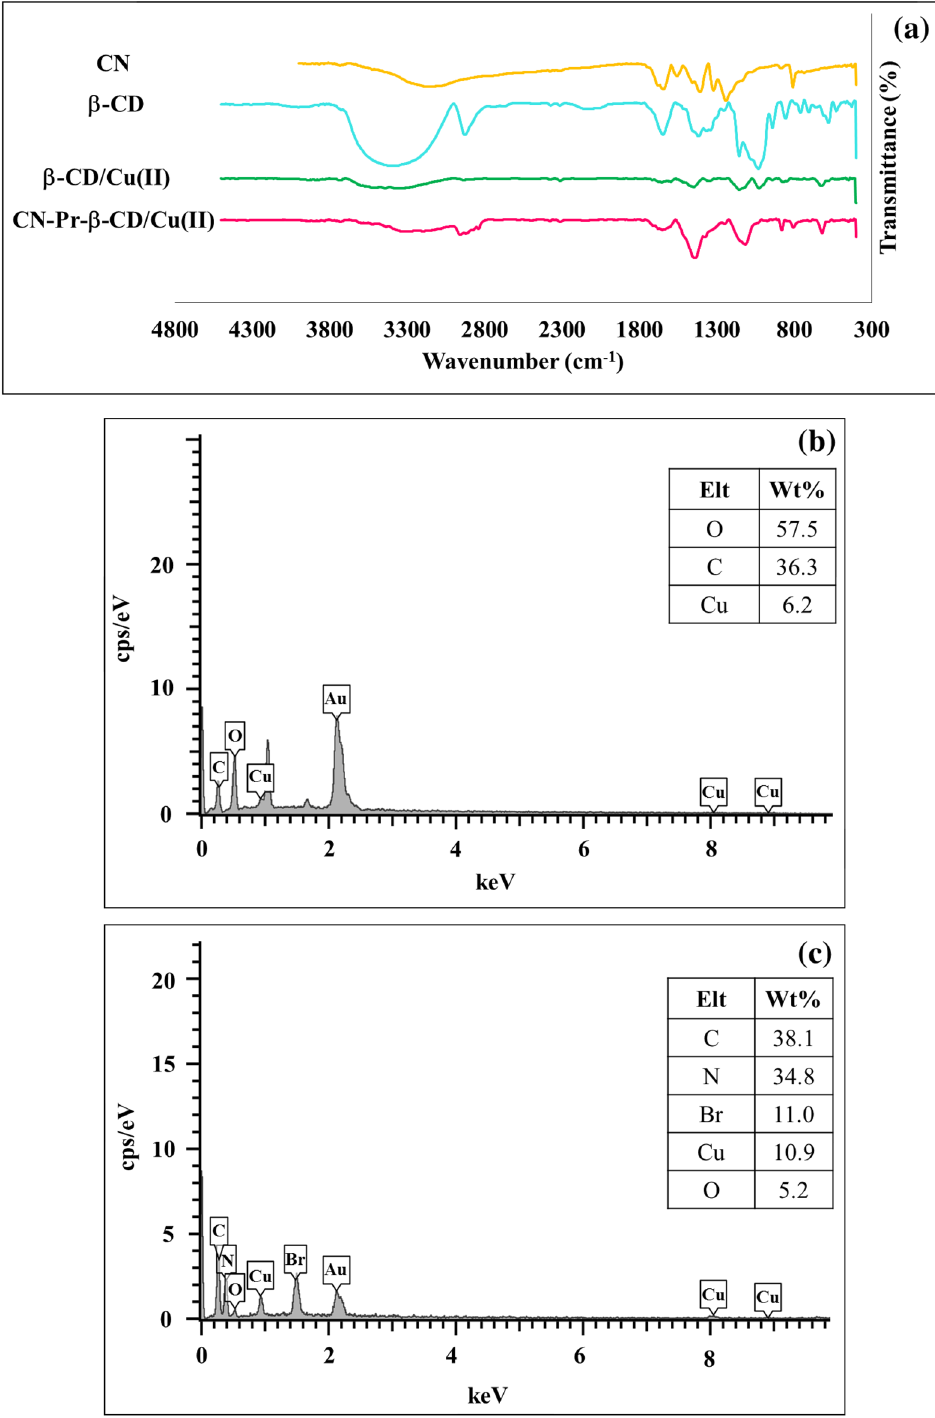
Figure 3. ( a ) FT-IR spectra of CN, β-CD, β-CD/Cu(II), CN-Pr-β-CD/Cu(II), ( b ) EDS analysis of β-CD/Cu(II), and ( c ) EDS analysis of